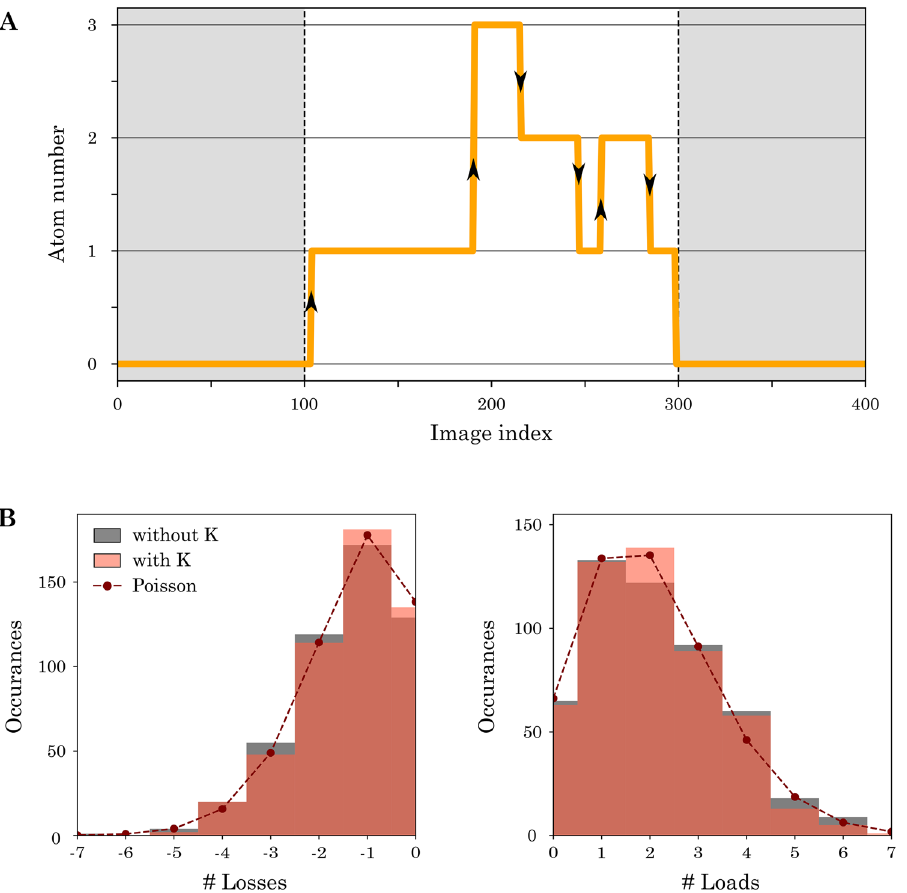
Figure 7. Counting statistics of sodium with and without potassium atoms present. A: Digitized example time trace of sodium with single atom load (loss) events marked with up (down) arrows. Only jumps during the MOT loading stage are taken into account. B: Histogram of the number of single atom losses and loads per time trace. The dashed lines show Poisson distributions with mean N loss and N load (extracted from the counting statistics).